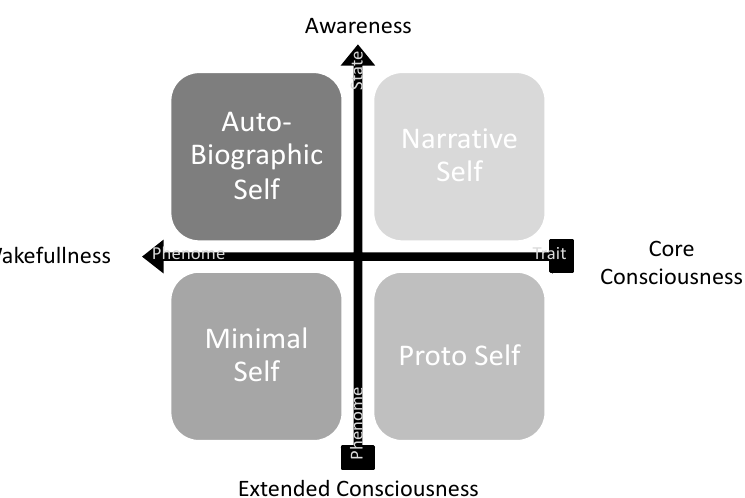
Figure 3. Neurophenomenological sampling and subgroup identification: constructs of self. A two-axis plot represents the Intervention Protocol, and the types of self [117]: Proto Self, Minimal Self, Narrative Self, and Autobiographic Self, stimulated in the two phases of the experimental procedure. On the horizontal axis, the progression of the mental trait is plotted, stimulating core consciousness to a more wakefulness trait. On the vertical axis, the progression of the mental state is plotted, enabling extended consciousness to a more awareness state. This figure was created following the work of the authors Hipólito and Martins [49].